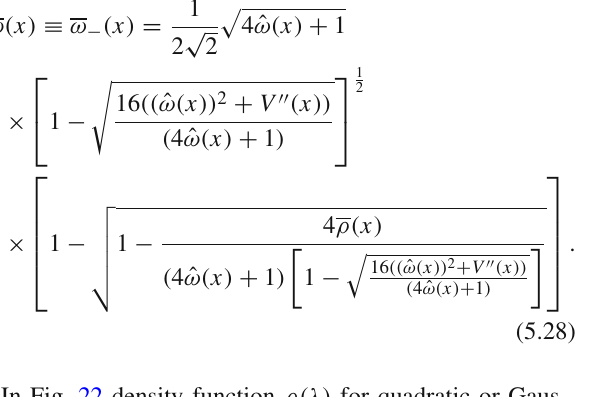
In Fig. 22 density function ρ(λ) for quadratic or Gaus- sian potential is plotted against λ with scaling factor 1 semicircle nature predicted from Eq.